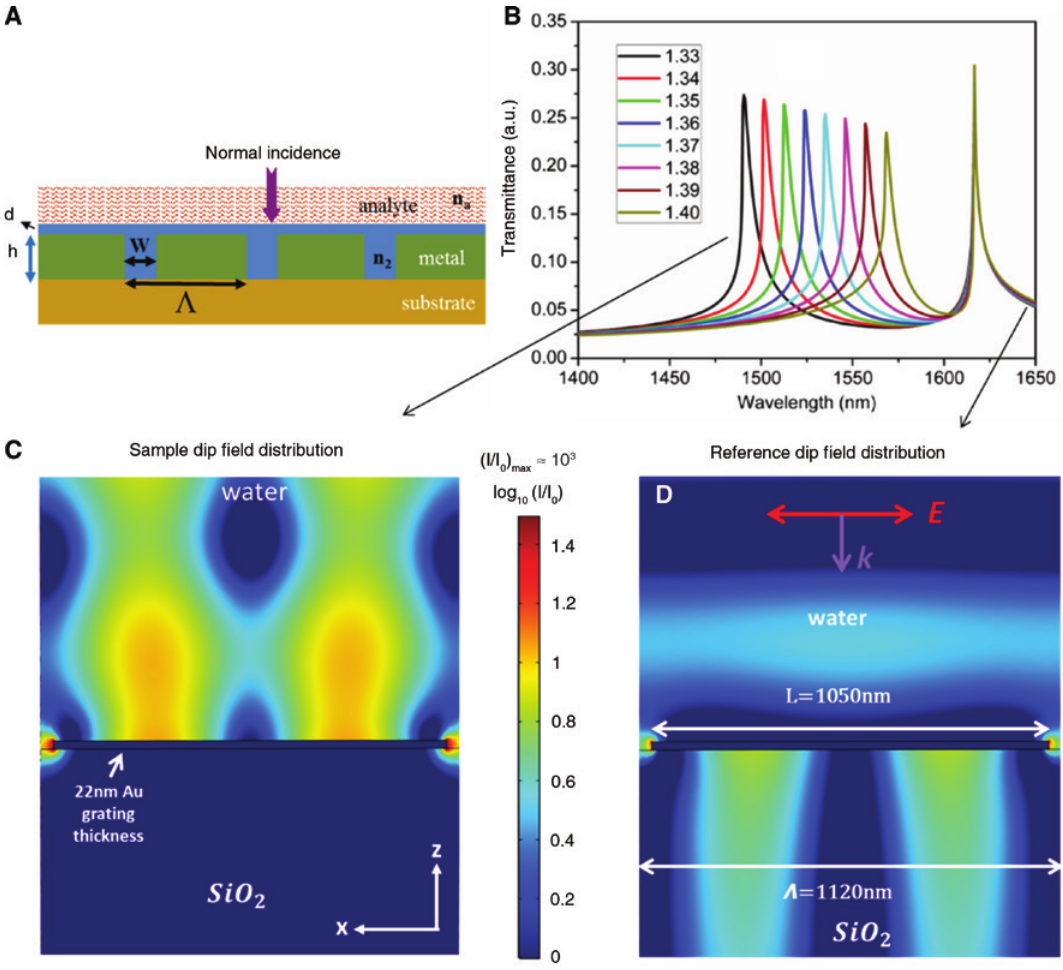
Figure 10: Field enhancement in the case of double SPR excitation using thin periodic array of metal nanoslits under EOT. EOT grating geometry (A), spectral transmission (B), and the field intensity distribution for each mode (C and D). Grating parameters are shown in the figure. Figure 10B is reproduced with permission from Reference